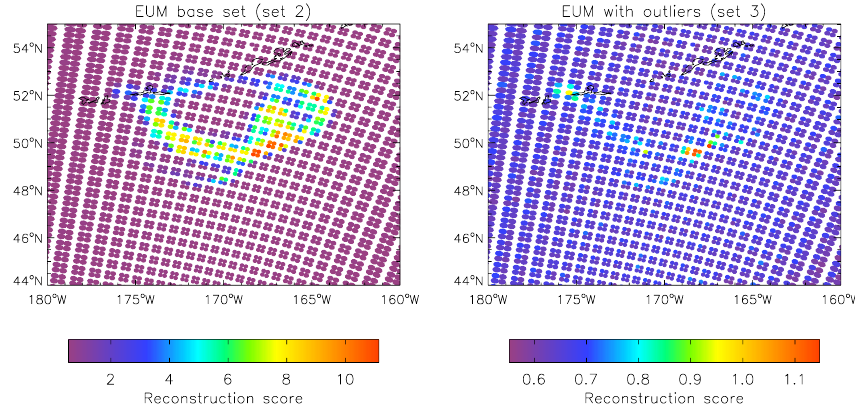
Fig. 7. Band 2 reconstruction scores for the Kasatochi eruption, showing the improvement in scores when outliers are included in the PC training set.